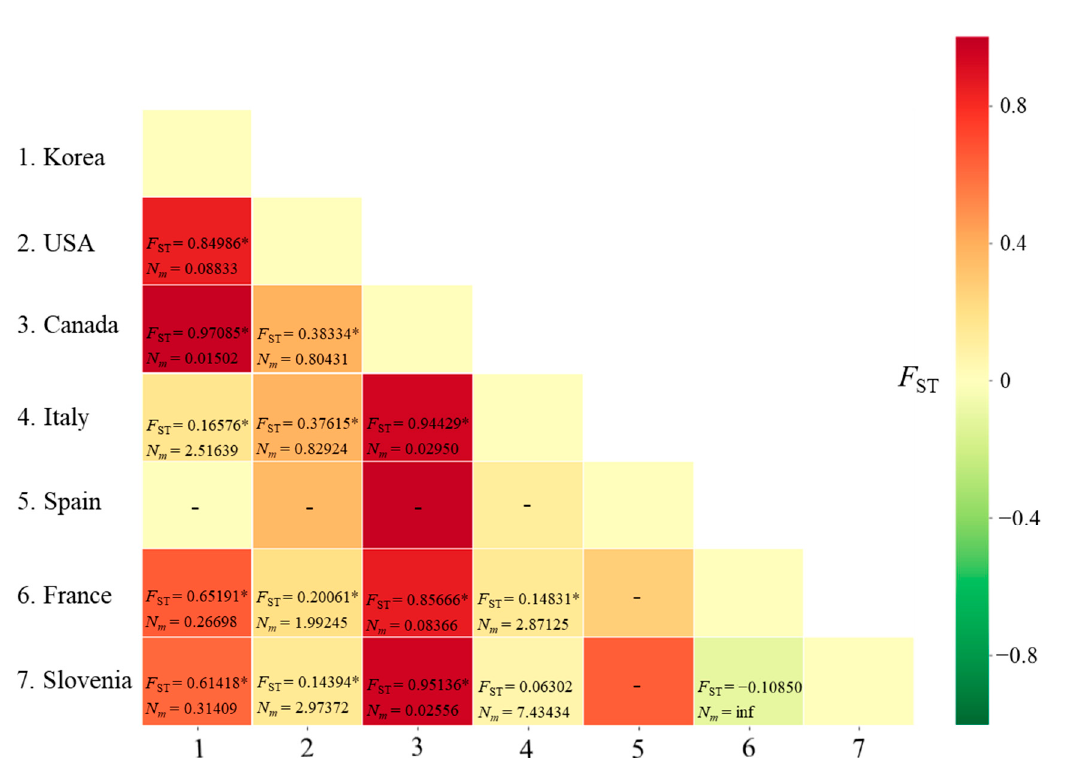
Numbers in parentheses indicate the sample size for each population.